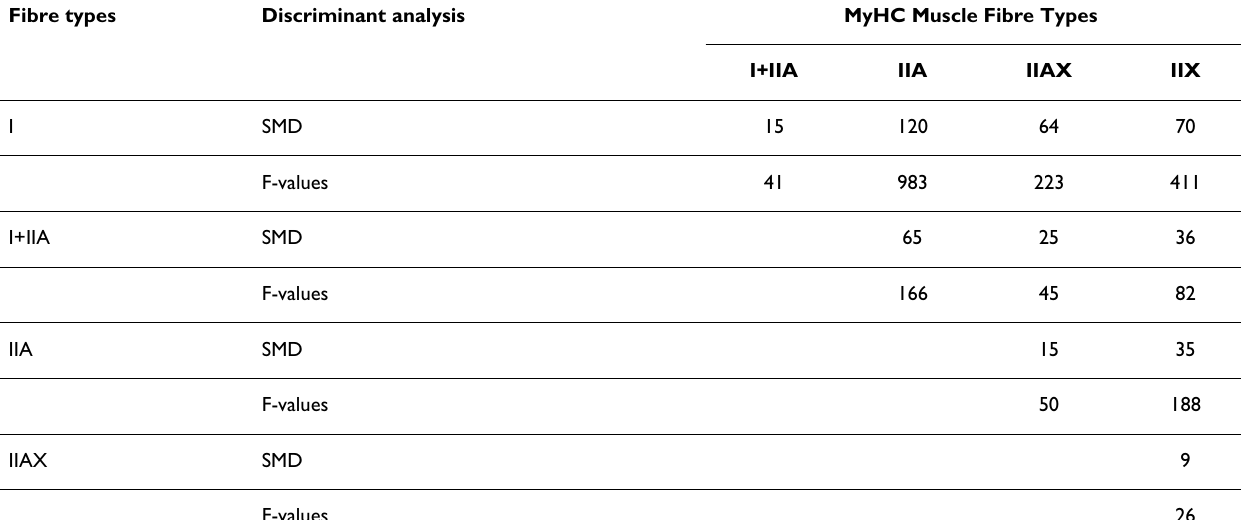
Table 4: Squared Mahalanobis Distances and F-values by discriminant analysis Fibre